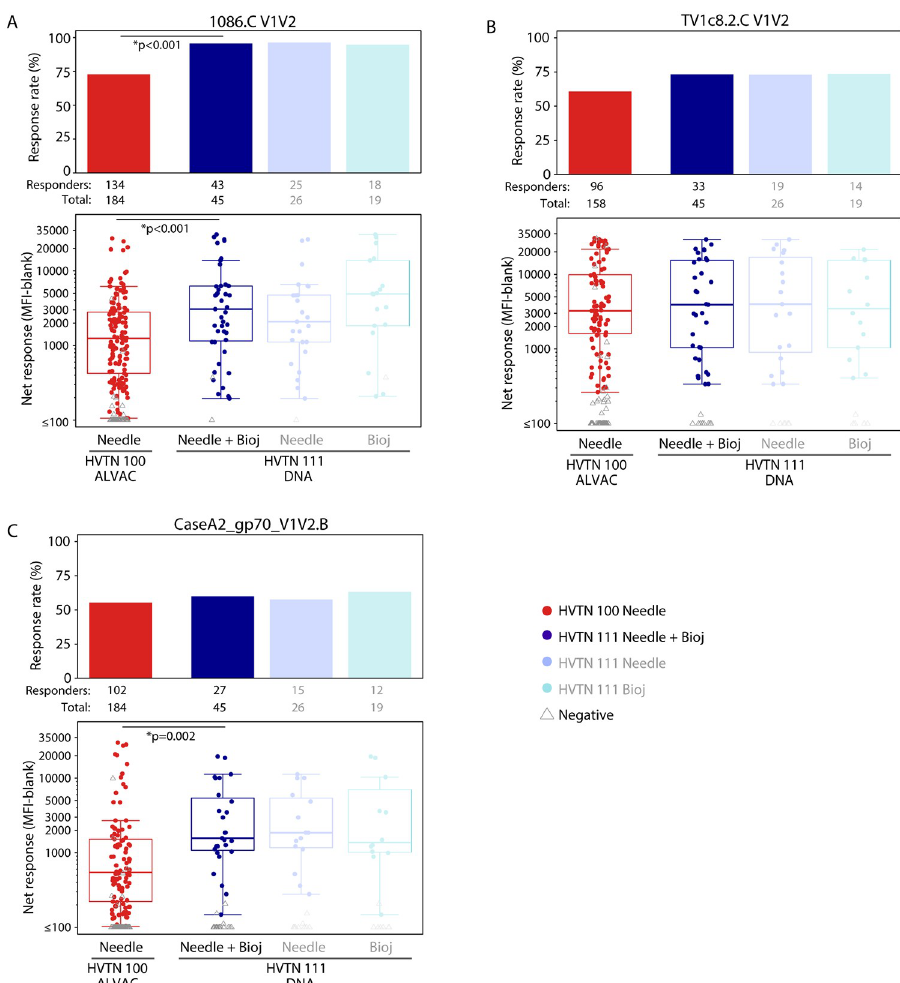
Fig 3. IgG bAb responses to V1V2 antigens among per-protocol vaccine recipients at month 6.5. Bar charts show the observed, unadjusted positive response rates. Boxplots show observed responses and are based on positive responders only (shown as colored circles), negative responders are shown as grey triangles. � TMLE p -values reported; Barnard/Wilcoxon p -values < 0.005. HVTN 100 is compared only to the combined arms of HVTN 111 (shown in dark blue) as no differences were seen between the needle and Biojector arms of HVTN 111 (shown in pale blues). bAb, binding antibody; HVTN, HIV Vaccine Trials Network; MFI, mean fluorescence intensity; TMLE, targeted minimum loss estimation; V1V2, variable 1 and